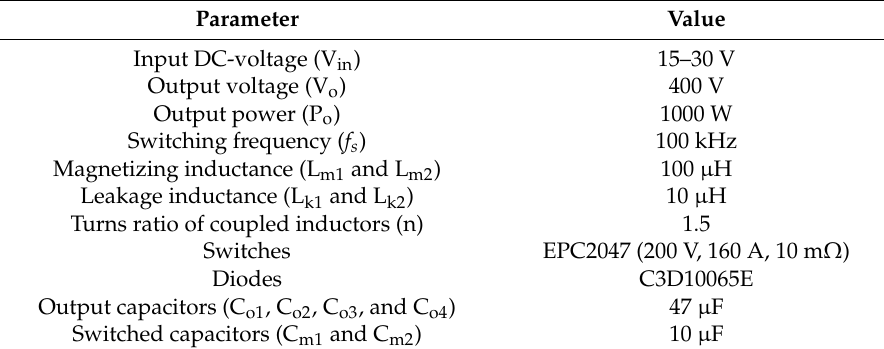
Table 2. Parameters and components of implemented converter.